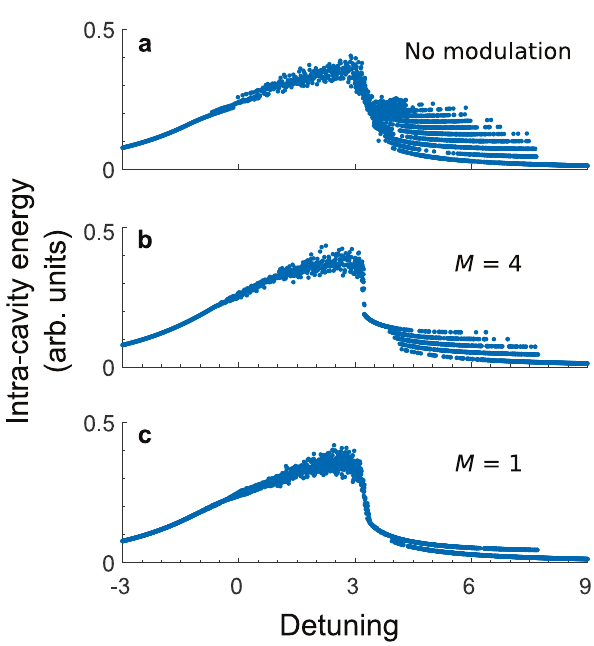
Fig. 5 Discrete time crystals cannot form when modulation frequency matches the free spectral range (FSR). Intra-cavity energy versus detuning α curves for microcombs without ( a ) and with b , c pump modulation. System parameters are d 2 = − 2 × 10 − 2 , d m = 0 ( m ≥ 3), and f = 2.5; in b , c δ = 0.75. In the step-like pro fi les when 3 < α < 8, each step 0 M of higher energy indicates a stable state with one soliton peak more per round-trip time than the adjacent lower-energy one. The lowest-energy step signi fi es soliton-free states. a In the absence of modulation, different numbers of solitons can emerge per round-trip time and the relative temporal delay between them is not dictated by the pump. b , c With modulation at an integer multiple of the FSR, a discrete time-translation symmetry is de fi ned by the drive and the maximum number of soliton peaks as well as their relative time delay becomes constrained by M = ω M / D M > 1, time-translation symmetry breaking (TTSB) is possible. The 1 . b For plot shows the case of M = 4 where frequency comb states lying on middle steps (i.e., steps other than the lowest- and highest-energy ones in the plot) correspond to discrete time crystals (DTCs) (cf. Fig. 2a, e). (c) When M = 1, neither of the possible states leads to TTSB (there is no middle step). Therefore, DTCs cannot form when ω M = D 1 . Intra-cavity energy has been normalized to ∣ f 0 ∣ 2 in all